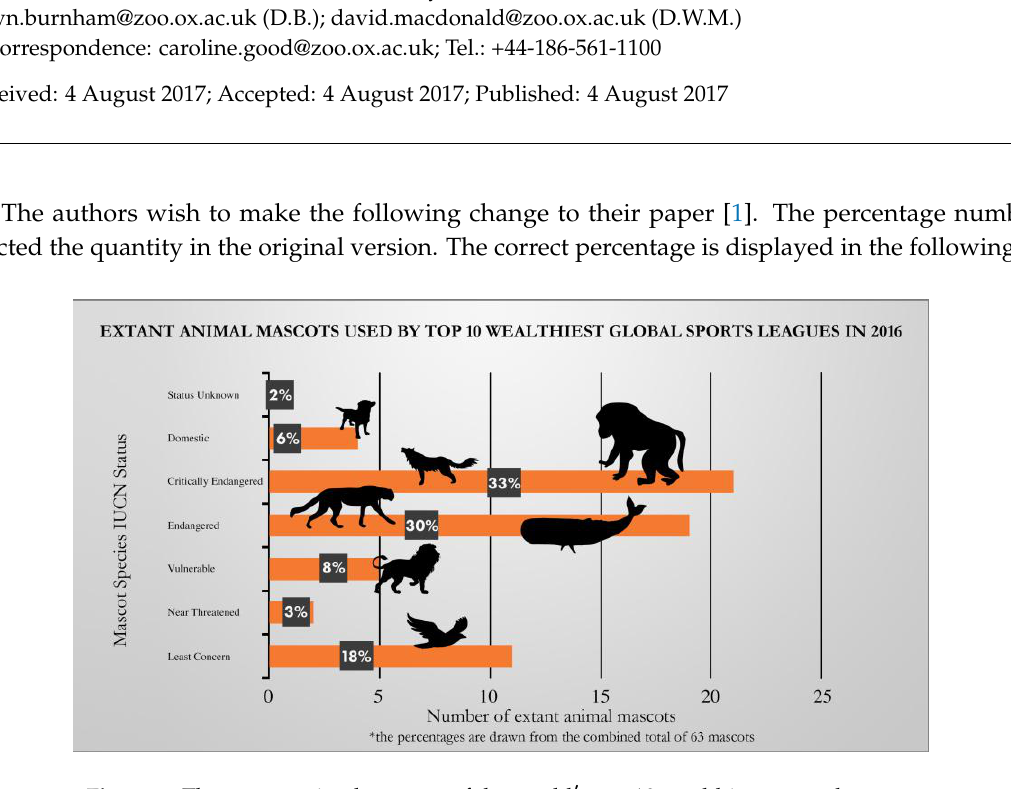
Figure 2. The extant animal mascots of the world′s top 10 wealthiest sports leagues.